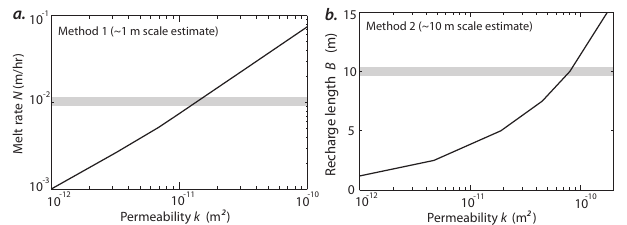
Fig. 7. Summary of permeability estimates from the two methods presented in the text. (a) Predicted permeability as a function of melt influx rate N ∗ from Eq. (2) and Llewellyn Glacier water ta- ble measurements. We assume porosity of φ = 0 . 1 here. (b) Perme- ability estimated from matching the phase lag between discharge at stream and melt input (Fig. 6a) as a function of recharge length scale B . Estimates for melt rate (a) and recharge length (b) are shown with grey